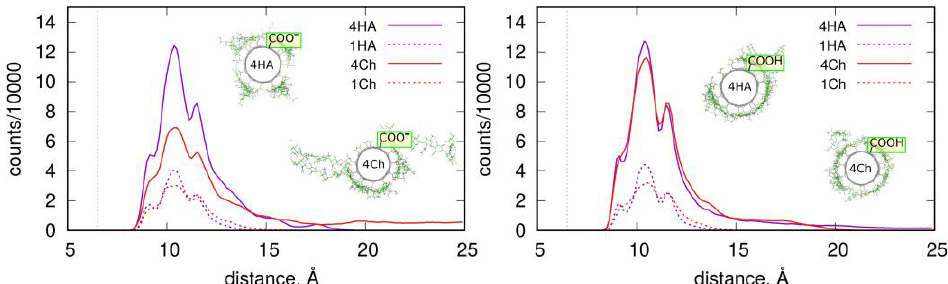
Figure 7. RDF of the HA (one and four HA) and Ch (one and four Ch) oligosaccharides adsorbed on the fCNT surfaces as a function of the distance from the fCNT axis. The dashed lines show the profiles of single molecule adsorption, while the solid lines are for the adsorption of four molecules.